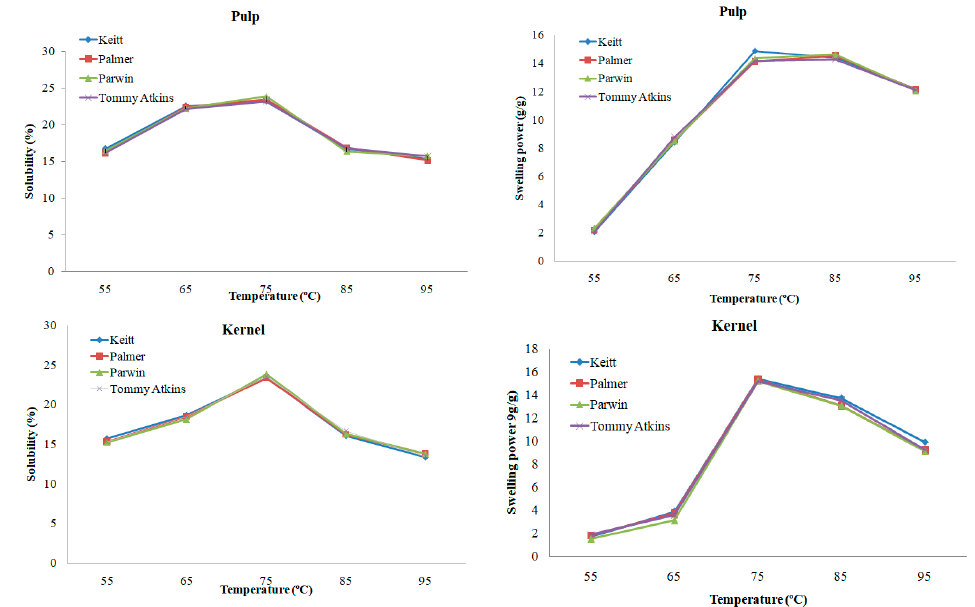
Figure 3. Swelling power and solubility of mango starches. Table 3. Solubility and swelling power of mango